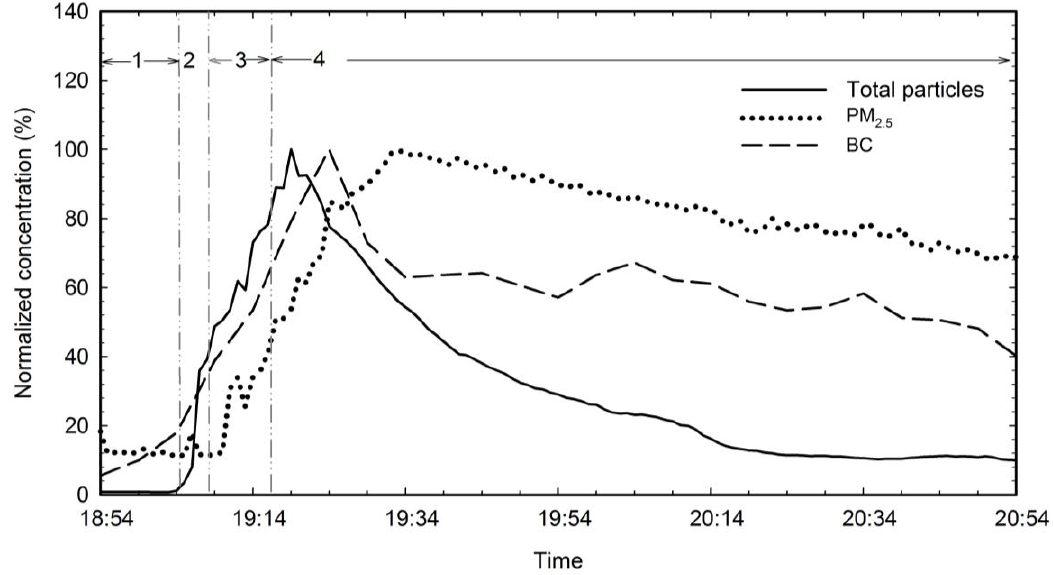
Figure 1. Normalized concentrations of total particle number concentration, PM concentration and BC mass concentration measured while cooking at high temperature on an electric stove with the exhaust fan turned on. The episode consisted of 4 periods: (1) background testing, (2) heating the pan and the oil, (3) frying the chicken and (4) post- cooking decay of emissions. Normalized concentrations are the fraction of pollutant concentrations based on the maximum concentrations measured in this cooking episode as follows: total particle number concentration: 4.27 × 10 5 particles/cm 3 , PM and BC: 0.6  g/m 3